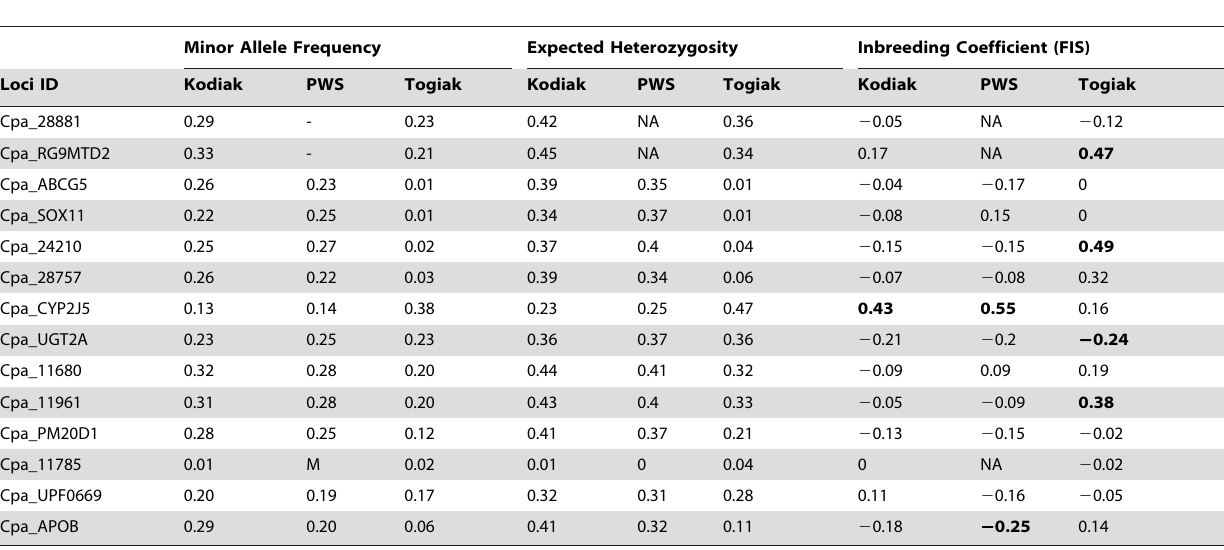
Table 4. Minor allele frequency, expected heterozygosity, and inbreeding coefficient ( F IS ) for select loci in three Pacific herring populations.